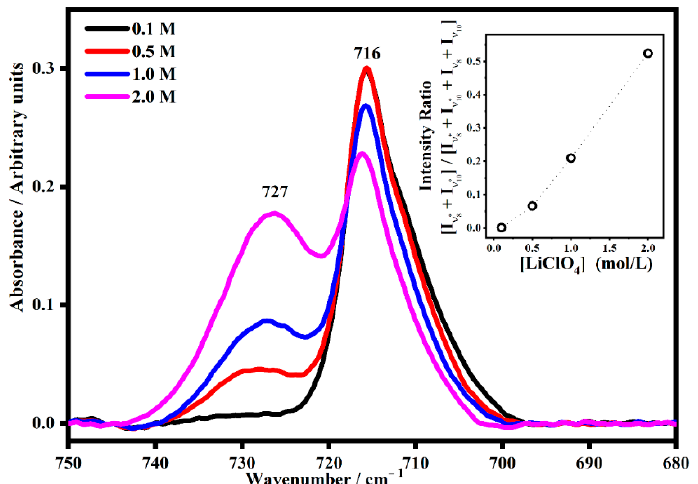
Figure 6. The IR band due to the sum of the PC mode denominated ν 10 and the EC mode denominated ν 8 (716 cm − 1 ) and its satellite band ( ν 8* + ν 10* ) due to the interactions between the plasticizers and the lithium ions (727 cm − 1 ) in PMMA-Li-PC-EC gel polymer electrolyte at different salt concentrations: 0.1 M, 0.5 M, 1 M and 2 M. In the inset, the trend of the intensity ratio [I ν 8* + I ν 10* ]/[I ν 8 + I ν 10 + I ν 8* + I ν 10* ] as a function of the salt concentrations.